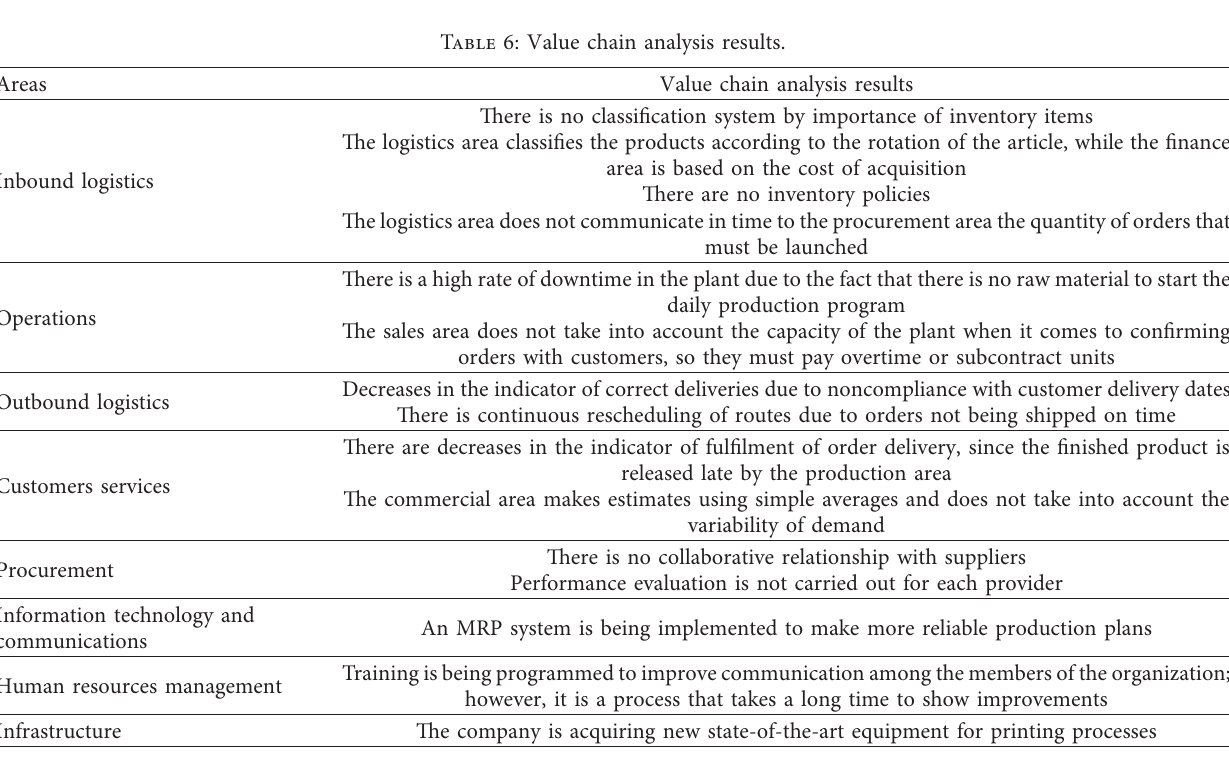
Table 6: Value chain analysis